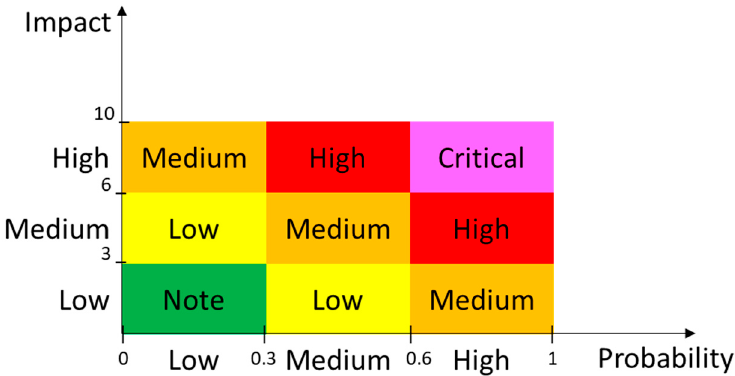
Figure 3. OWASP risk severity quadrants.